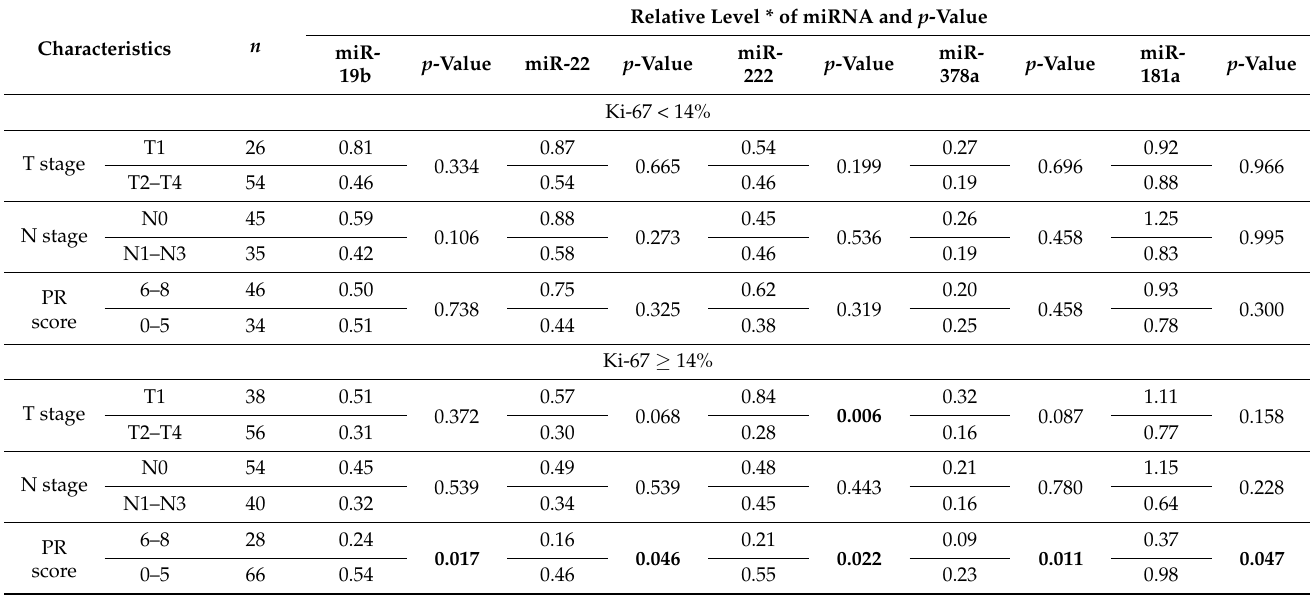
Table 7. Association of miR-19b, miR-22, miR-222, miR-378a and miR-181a expression with clinicopathologic characteristics of breast tumors with the Ki-67 index < 14% or ≥ 14.